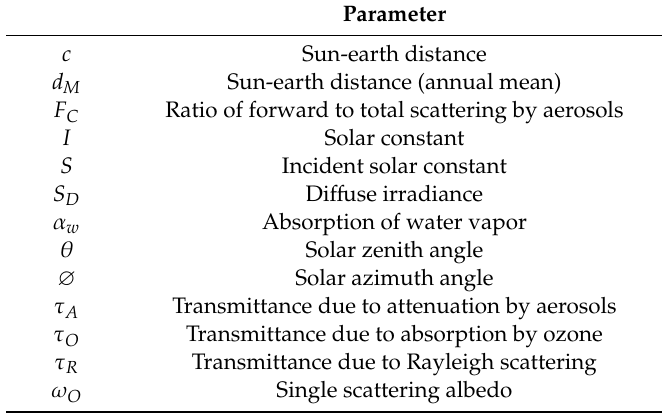
Table 2. Description of parameters used for estimation of satellite-based solar